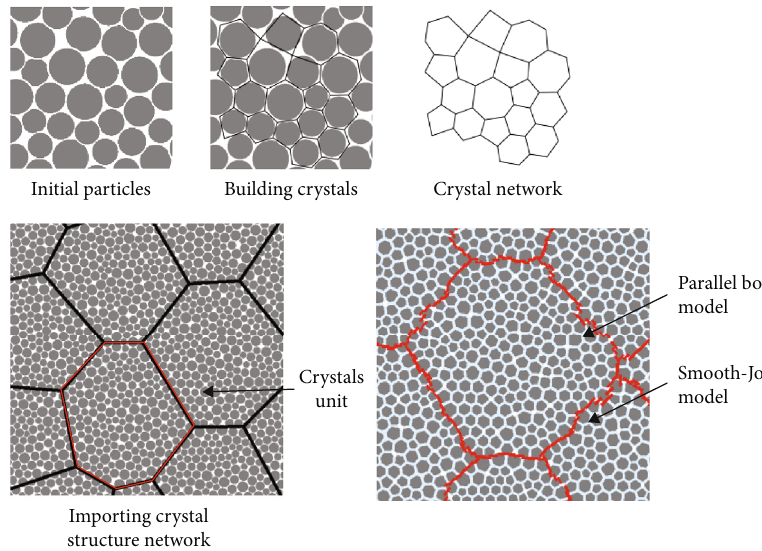
Figure 5: Generation diagram of new GBM model.